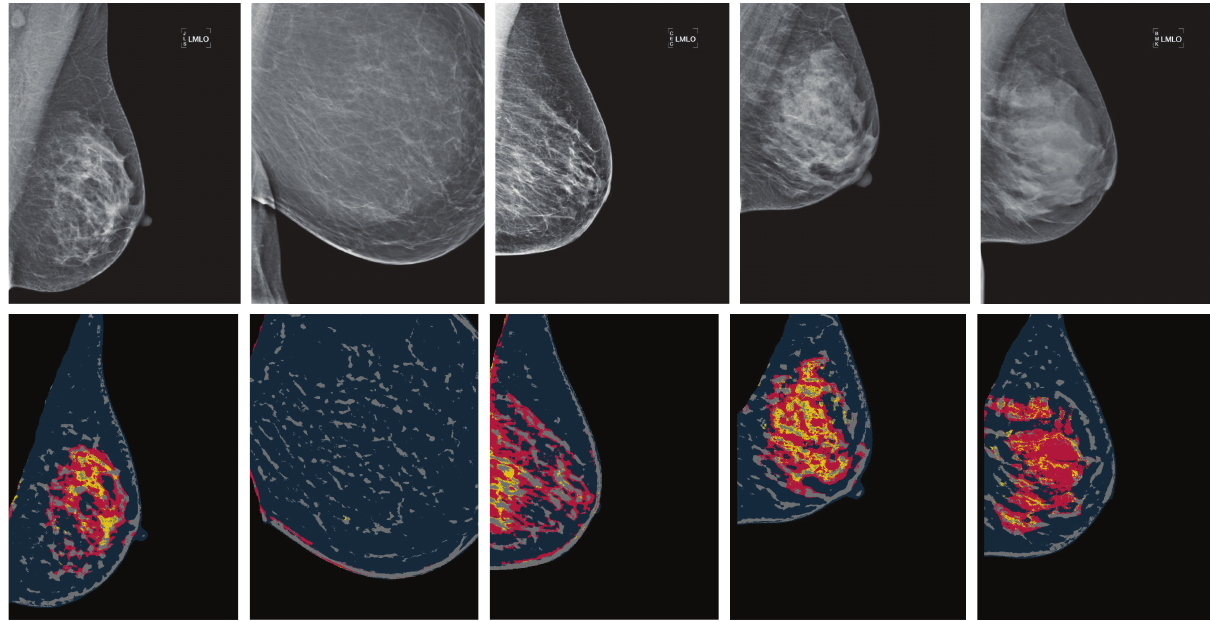
Figure 6: Example mammographic parenchymal segmentation. Images (digital mammograms) from left to right are rated with Tab´ar I–V, respectively. Nodular, linear structure, homogeneous, and radiolucent areas are colour coded as yellow, grey, red, and navy,